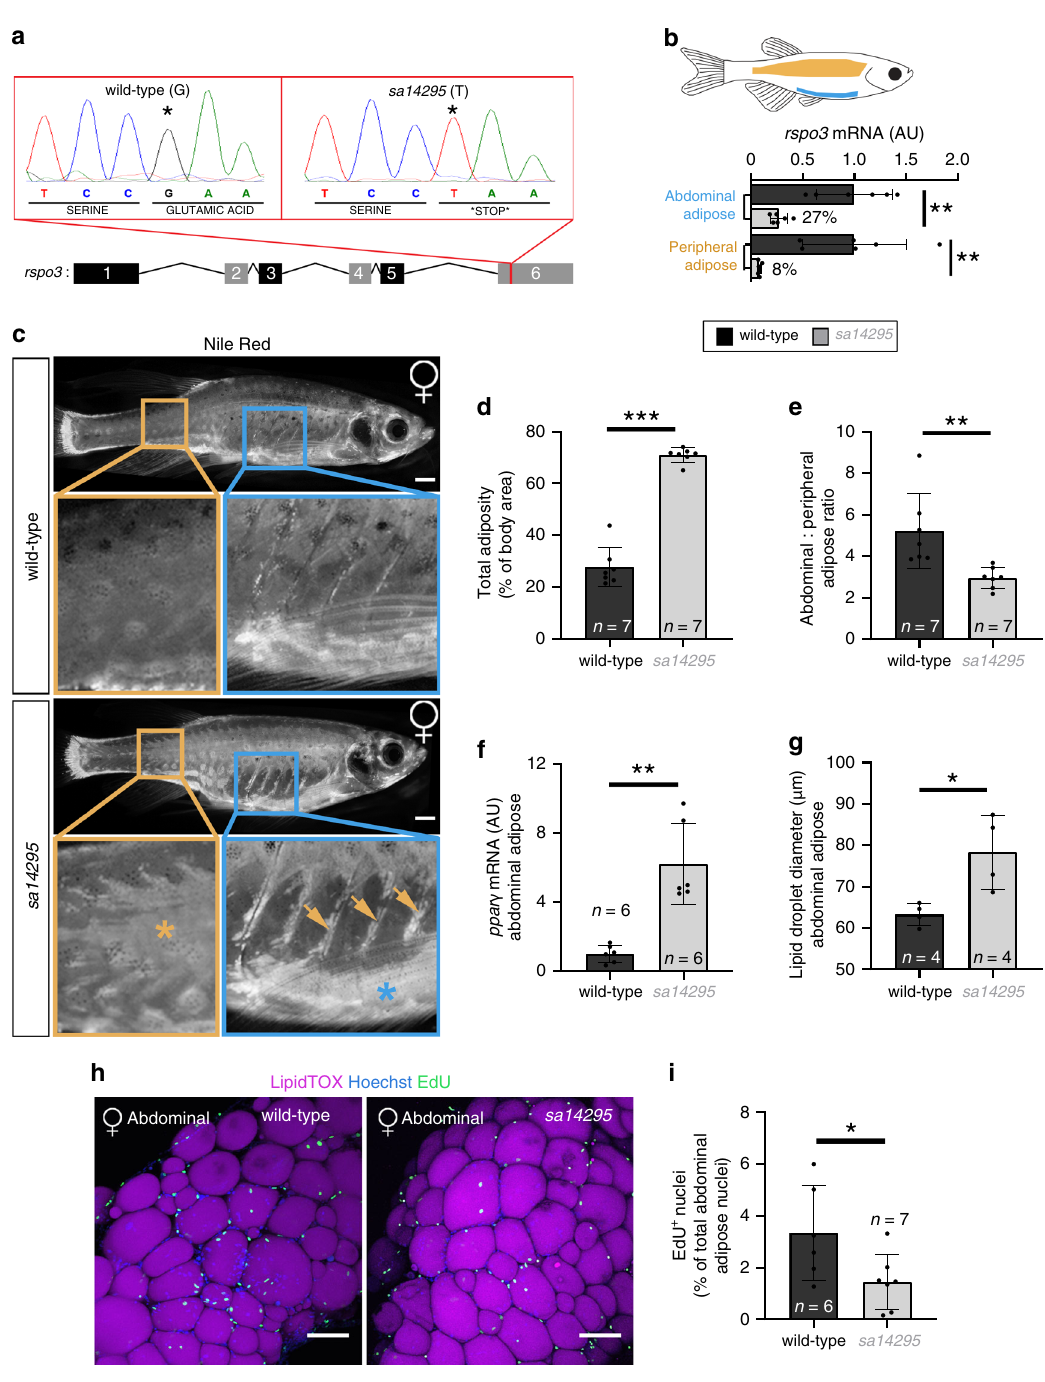
Fig. 6 Effects of a nonsense rspo3 mutation on total and regional adiposity in zebra fi sh. a Schematic illustrating the location of the sa14295 mutation in exon 6 of zebra fi sh rspo3. b qRT-PCR for rspo3 in abdominal and peripheral AT in wild-type sibling and sa14295 homozygous (rspo3 m/m ) adult females ( n = 6). c Nile Red staining of adult wild-type and rspo3 m/m females (the blue asterisk indicates abdominal AT, whereas, the orange asterisk indicates peripheral AT that extends ventrally as marked by arrowheads). Scale bars = 1 mm. d Total adiposity, expressed as the % of total adipose-lipid area relative to body area, is signi fi cantly increased in rspo3 m/m adult females. e The ratio of abdominal to peripheral SC AT is decreased in rspo3 m/m adult females. f ppar γ mRNA is elevated in the abdominal AT of rspo3 m/m adult females. g Adipocyte-localised lipid droplets are signi fi cantly larger in rspo3 m/m adult females. h Maximum intensity projection of female abdominal AT stained with LipidTOX (magenta), Hoechst (blue) and EdU (green). Scale bars = 100 μ m. i Quanti fi cation showing decreased EdU + nuclei in abdominal AT of rspo3 m/m animals. Two-tailed unpaired Student ’ s t -test was used for comparisons between genotypes ( b , d – g and i ). Histogram are means ± s.d. * p < 0.05, ** p < 0.01, *** p < 0.001. Source data are provided as a Source Data fi